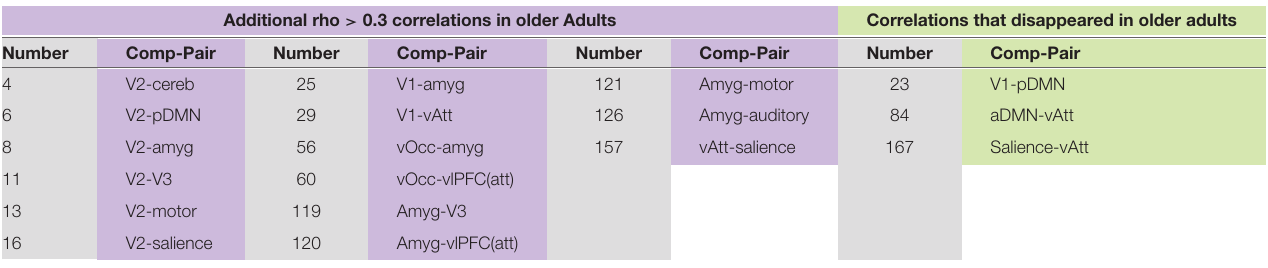
TABLE 3 | High-correlation component-pairs gained and lost with aging. Additional rho > 0.3 correlations in older Adults Correlations that disappeared in older